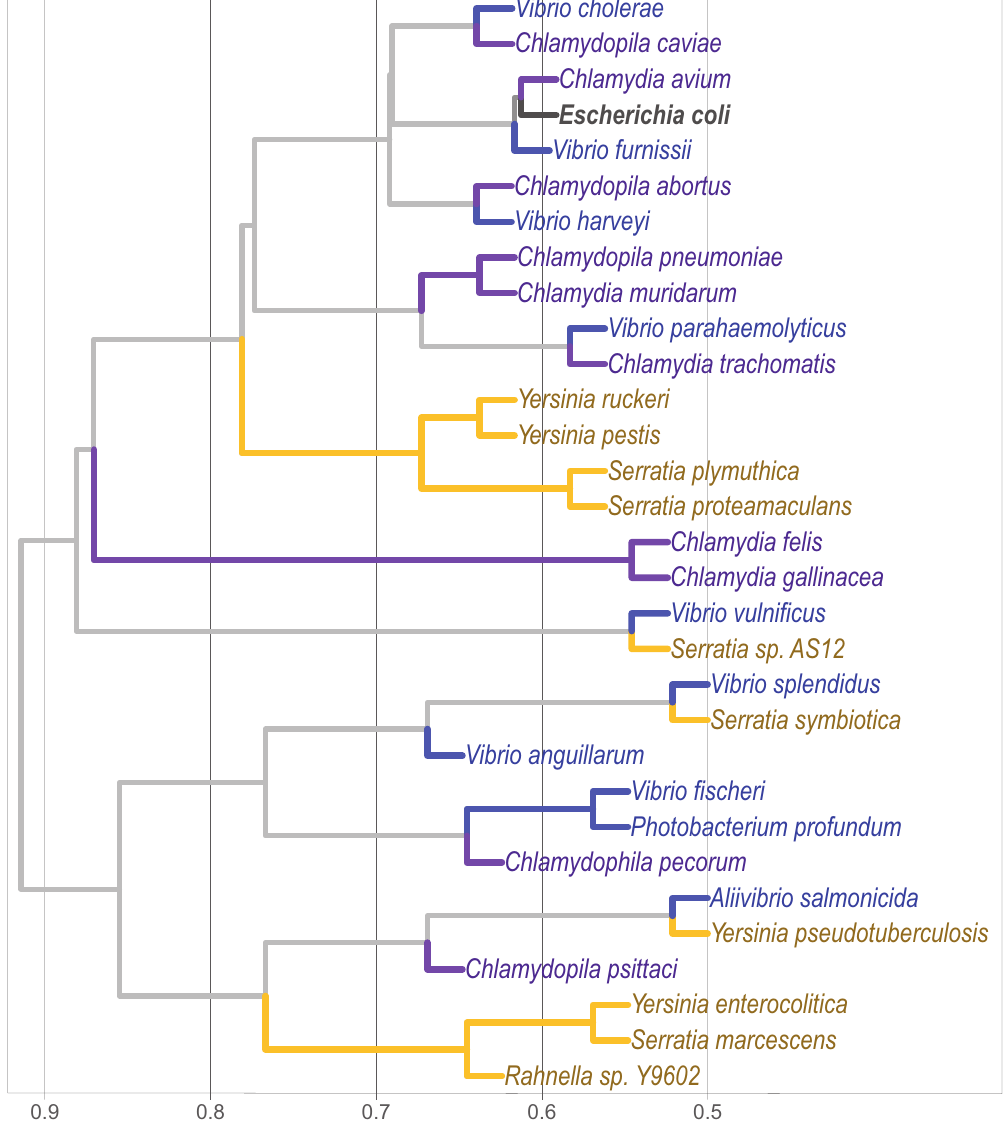
Figure 4. Phylogenomic classification of bacterial families Chlamydiales , Vibrionaceae , and Yersiniaceae based on the methodology of Sims and Kim [3], and including over-represented